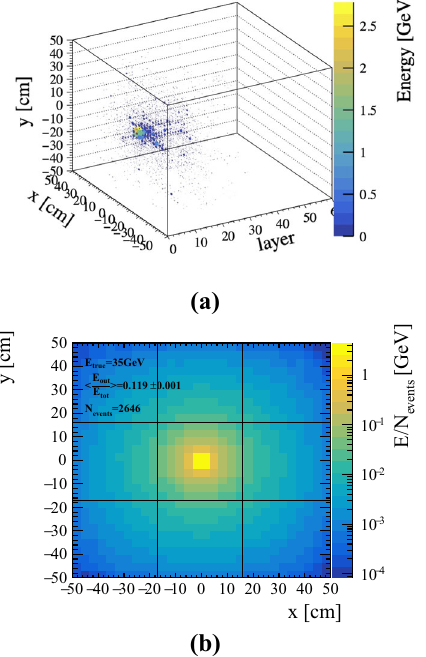
Fig. 3 Energy resolution ( a ) and linearity ( b ) for different transverse granularities with 1 longitudinal layer (stage 0). The curves show the fit to the form given in Eq. (1)